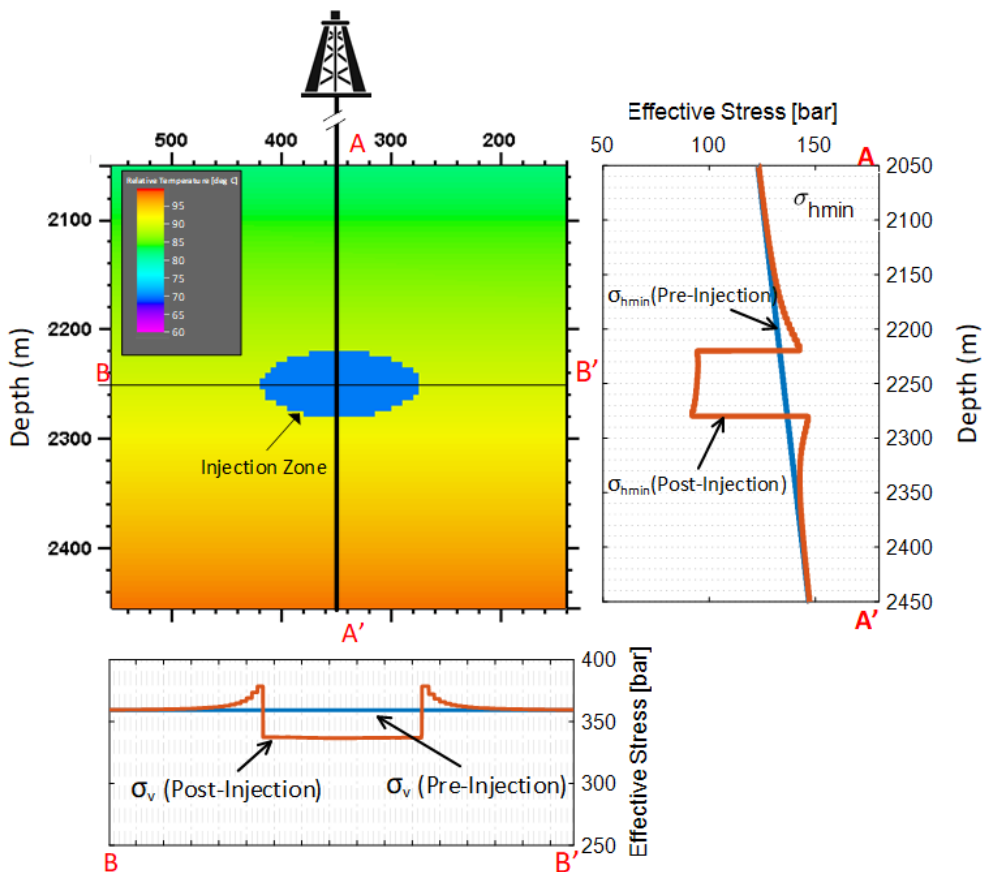
Figure 7. Induced thermal stress resulting from cold fluid injection into a geothermal reservoir. The color scale is the relative temperature range from 60 to 100 ◦